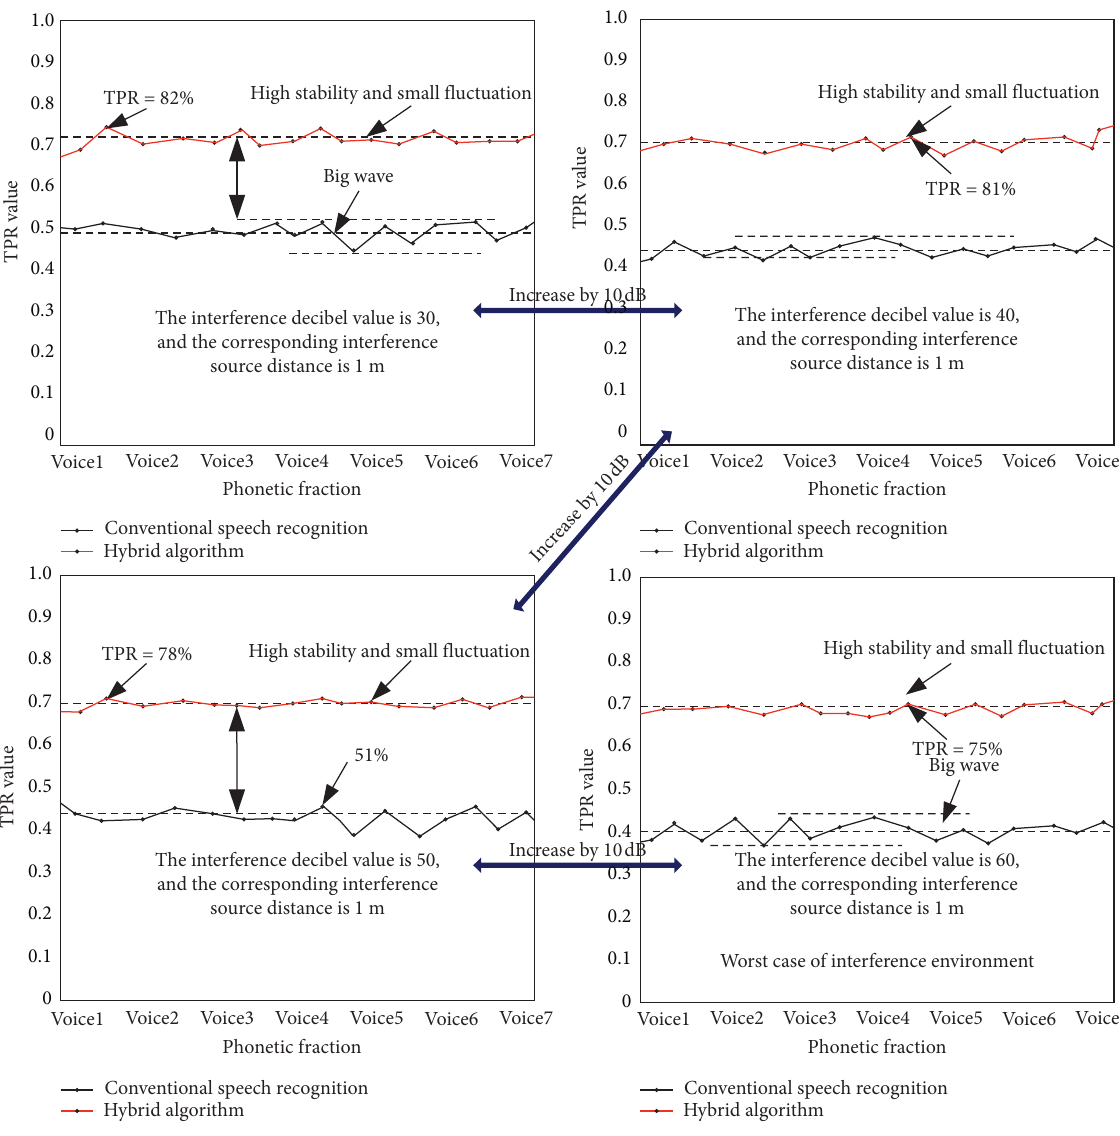
Figure 8: Comparison of anti-interference performance of test